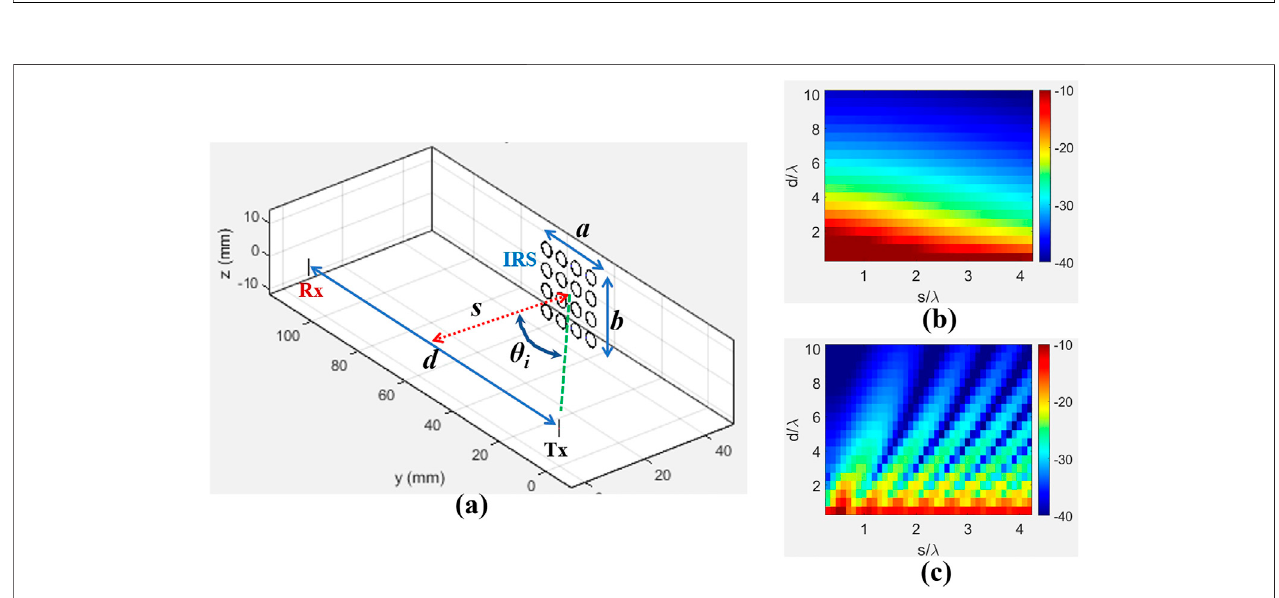
FIGURE9|(A) SchematicdiagramofSISOLinkcomprising ofaTxandRxdipoleplaced10 λ awayfromeachother,with8 × 8Loop-arrayasIRSplaced1.5 λ away from the Tx-dipole. (B) Top fi gure shows the Frequency variation of path-loss i.e. S21 for the Tx-Rx system without IRS | S noIRS 21 | . Bottom fi gure shows the impact of IRS size on the Δ P (see (2)) over the wide frequency range.